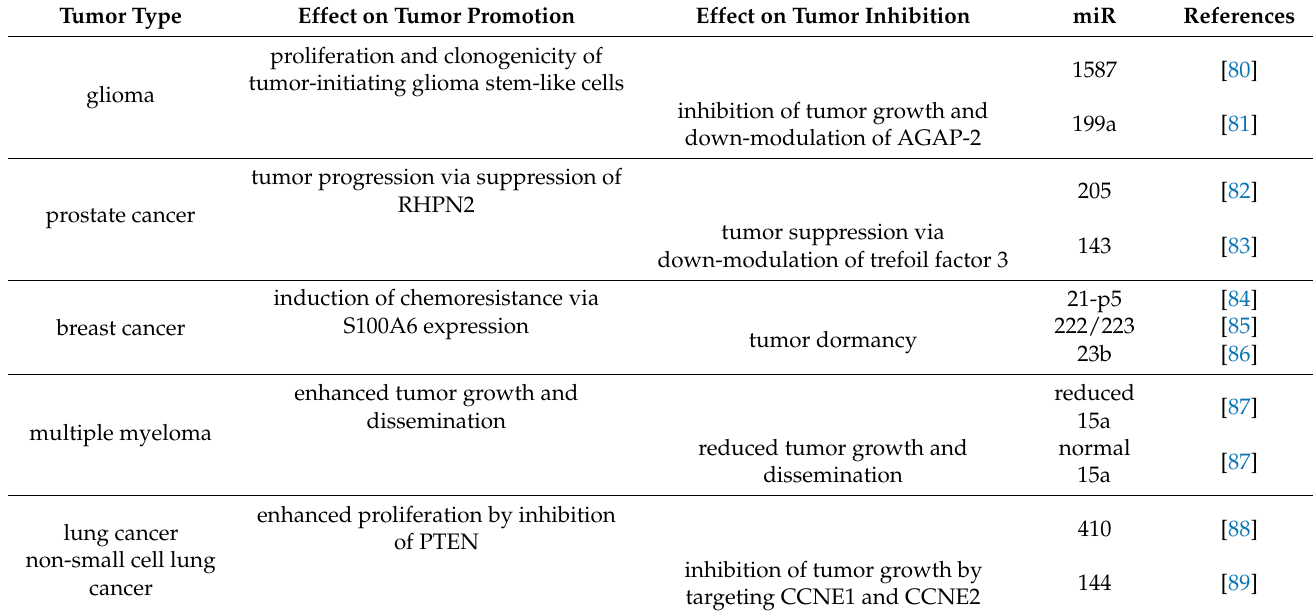
Table 1. MSC-derived exosomes contain miRs with tumor-promoting and tumor-inhibitory effects. Tumor